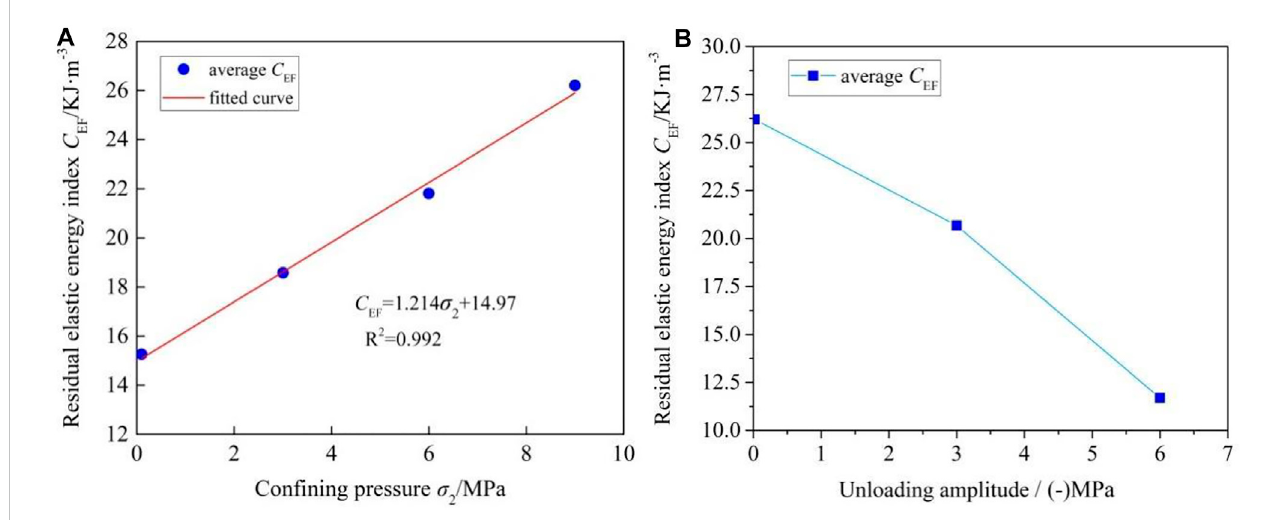
FIGURE 12 Residual elastic energy index of coal specimen (A) under con fi ning pressure conditions and (B) under unloading